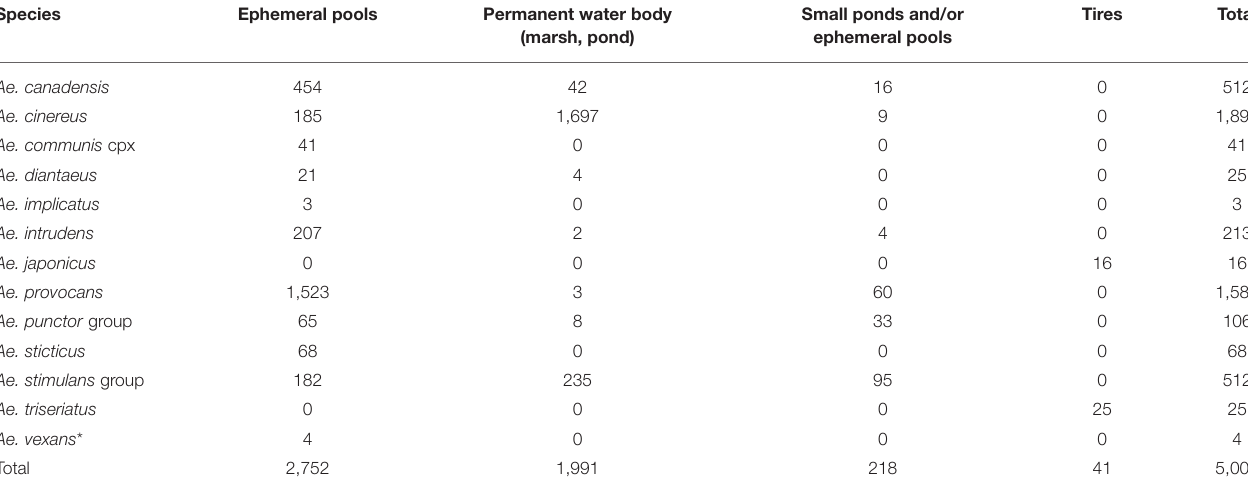
TABLE 2 | Total number of immature mosquitoes collected in Sawyer County in 2019, according to larval habitat.